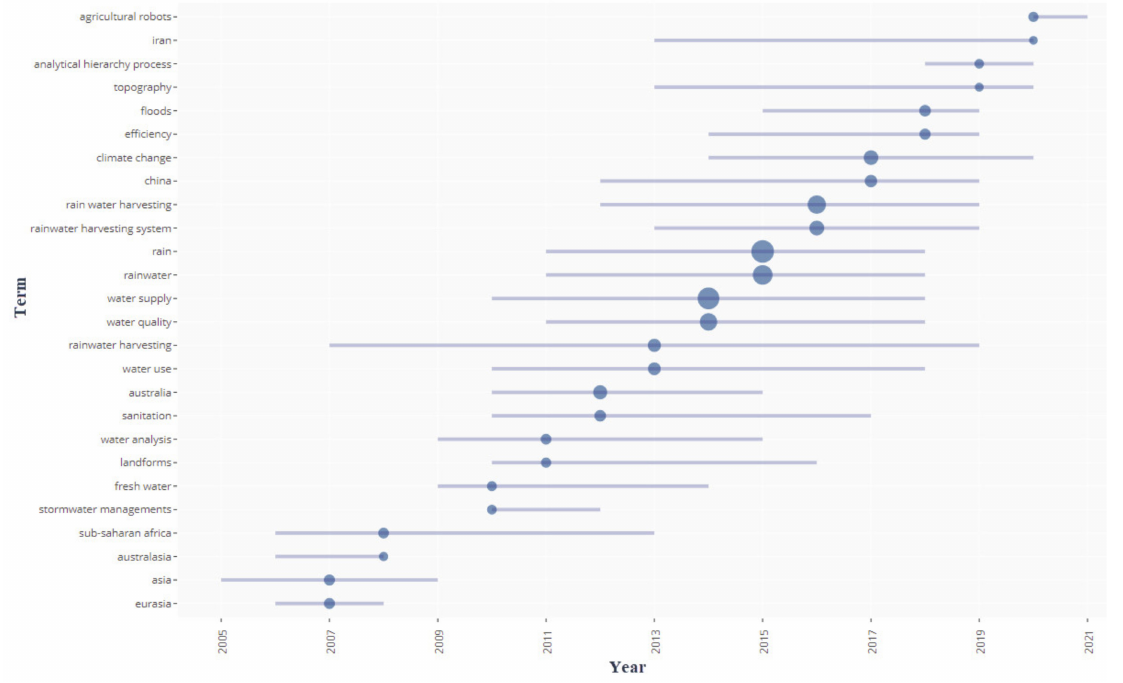
Figure 6. Trend topics on RWH field,